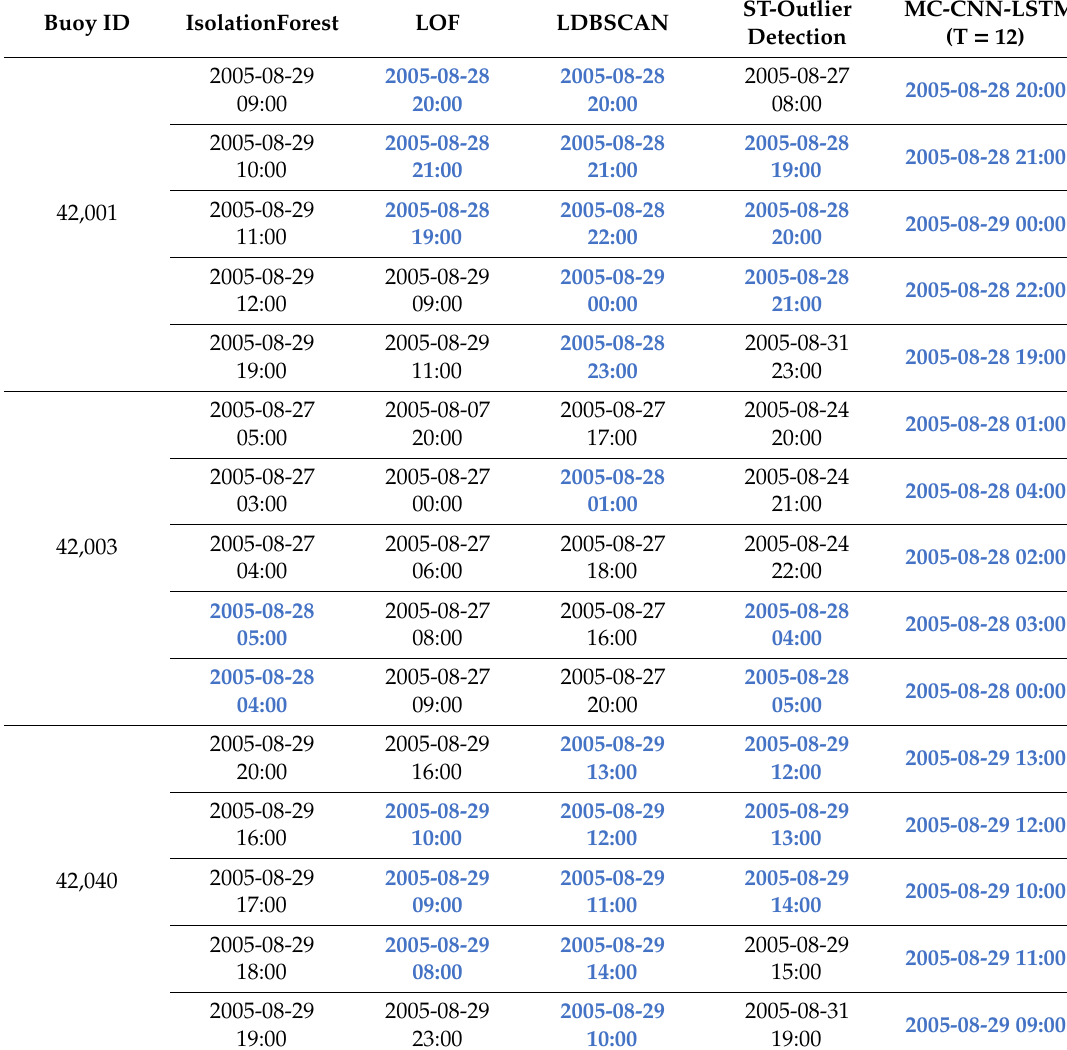
Table 2. Timestamps of detected anomalies. Anomalous data points which are in the spatio-temporal neighborhood of the Hurricane Katrina are given in